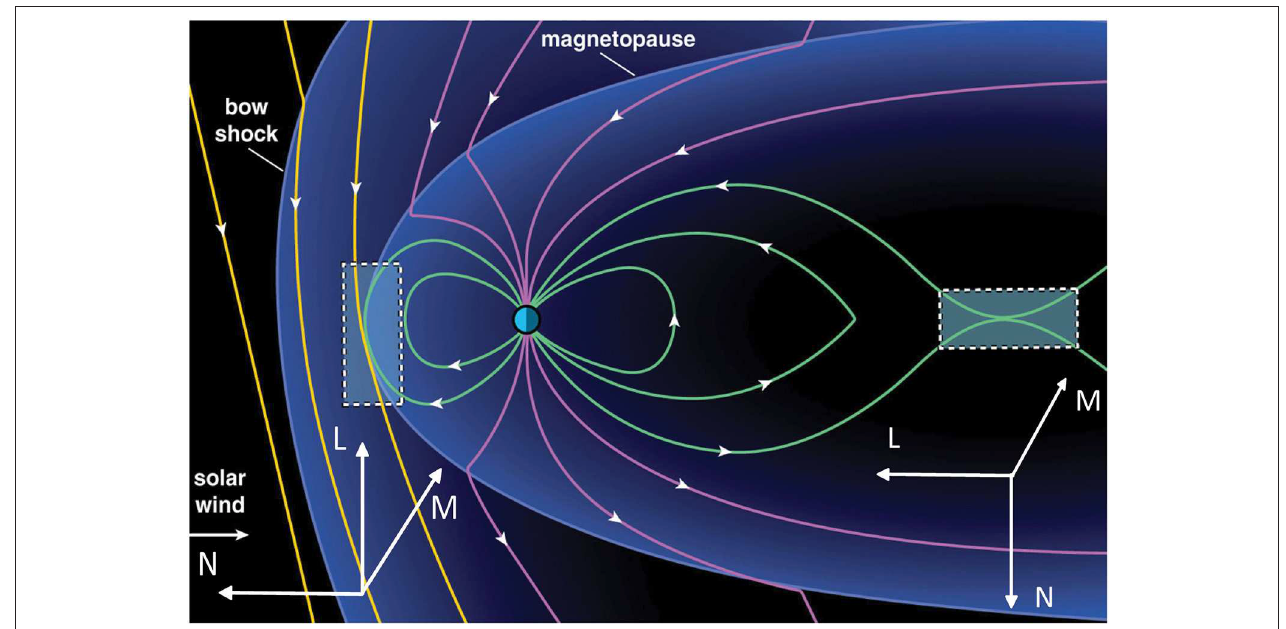
FIGURE 1 | Magnetic reconnection in the magnetosphere during southward magnetic field in the solar wind. Reconnection sites are indicated by two box areas. The LMN coordinate system represents the local normal boundary coordinate system for reconnection at different locations: L is the direction of the reconnecting magnetic field line, M is tangential to the normal and in the direction of the electric current, and N is the normal direction to the boundary layer. The figure is modified from Figure 1 of Burch et al. [2] under the terms of the Creative Commons Attribution 4.0 International License